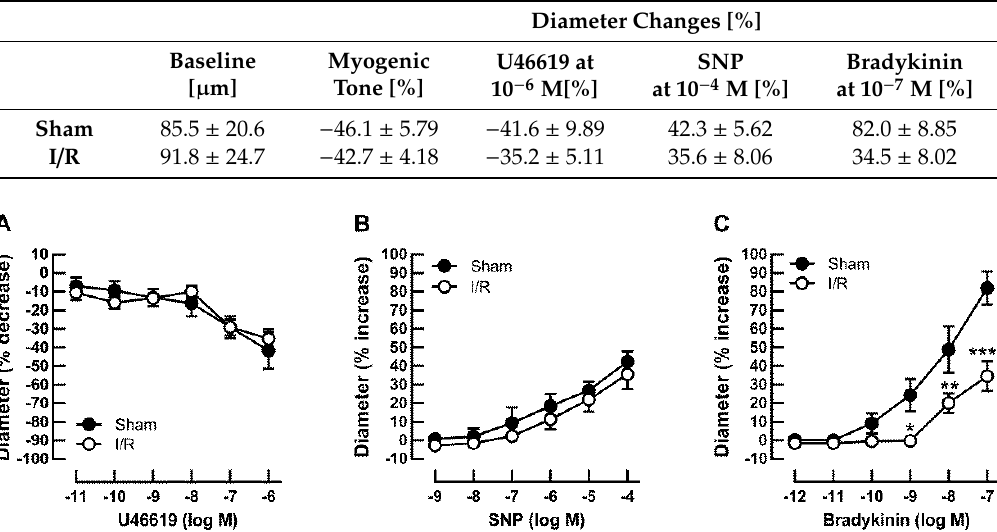
Figure 2. Concentration-dependent responses in retinal arterioles from I / R- and sham-treated pigs to U46619 ( A ), the endothelium-independent vasodilator, SNP ( B ), and to the endothelium-dependent vasodilator, bradykinin ( C ). Data are expressed as mean ± SE ( n = 6 per concentration and group; * p < 0.05, ** p < 0.01, **** p <